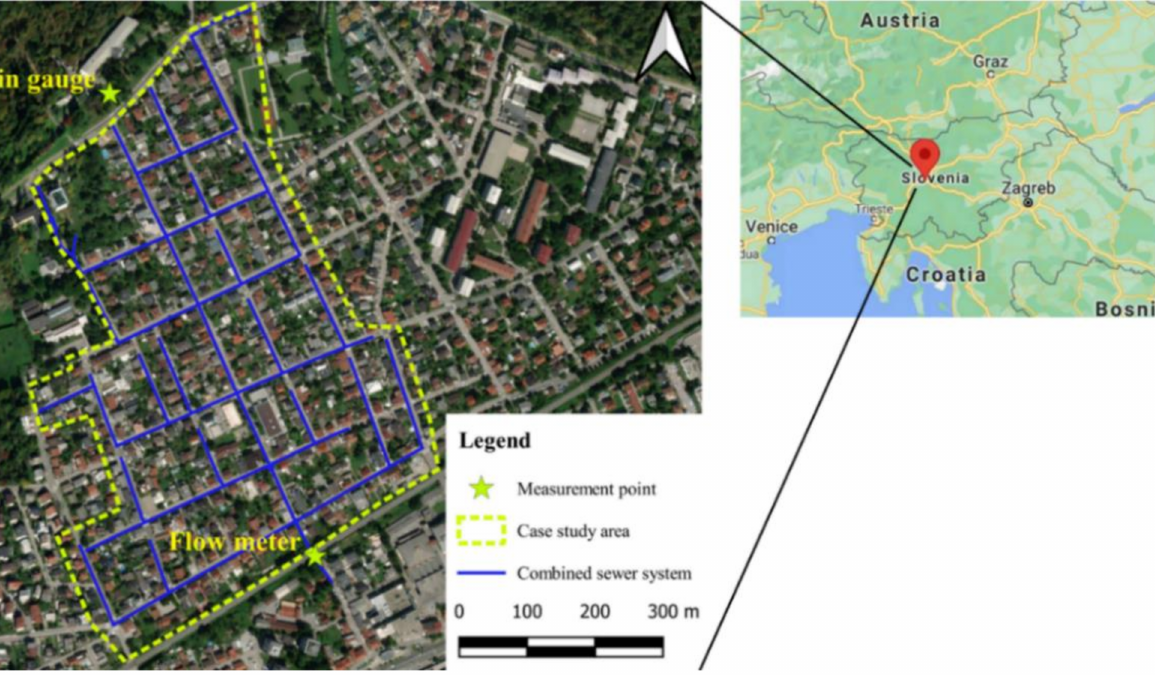
Figure 1. Case study